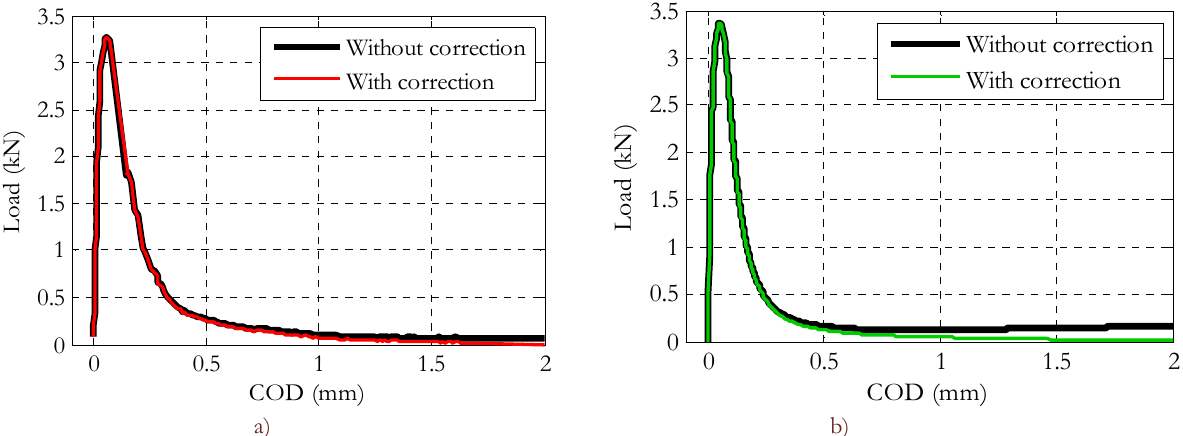
Figure 13: Original and corrected fracture energy curves for specimen 2: a) experimental and b) numerical results. 